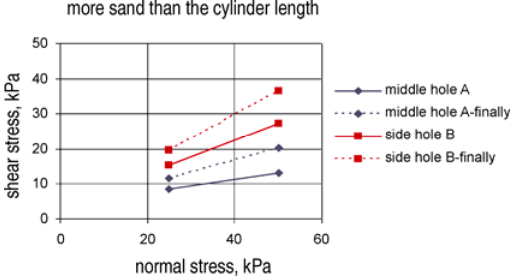
Fig 17 . Distribution of horizontal component of stress x σ during test if there is slightly more sand in the cylinder than its length